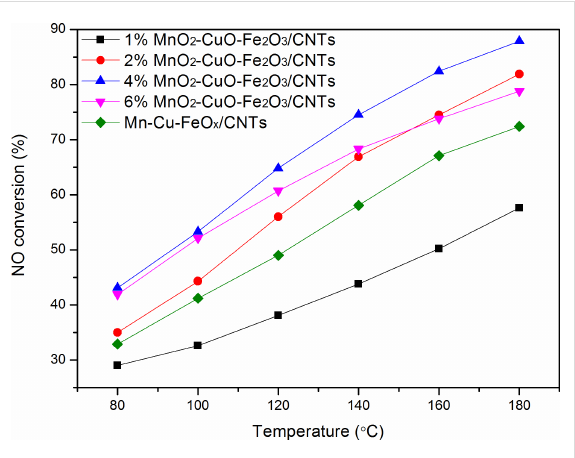
Figure 1: NO conversion as a function of the temperature over CNT - based catalysts. Reaction conditions: [NO] = [NH 3 ] = 400 ppm, [O 2 ] = 5%, N 2 as balance gas, WHSV=280 L·g cat − 1 ·h − 1 , 0.15 g cata- lyst.